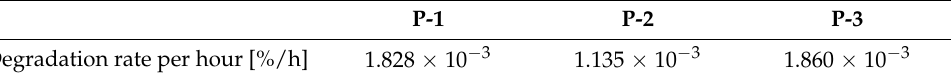
Table 8. Performance degradation rate of pumps.